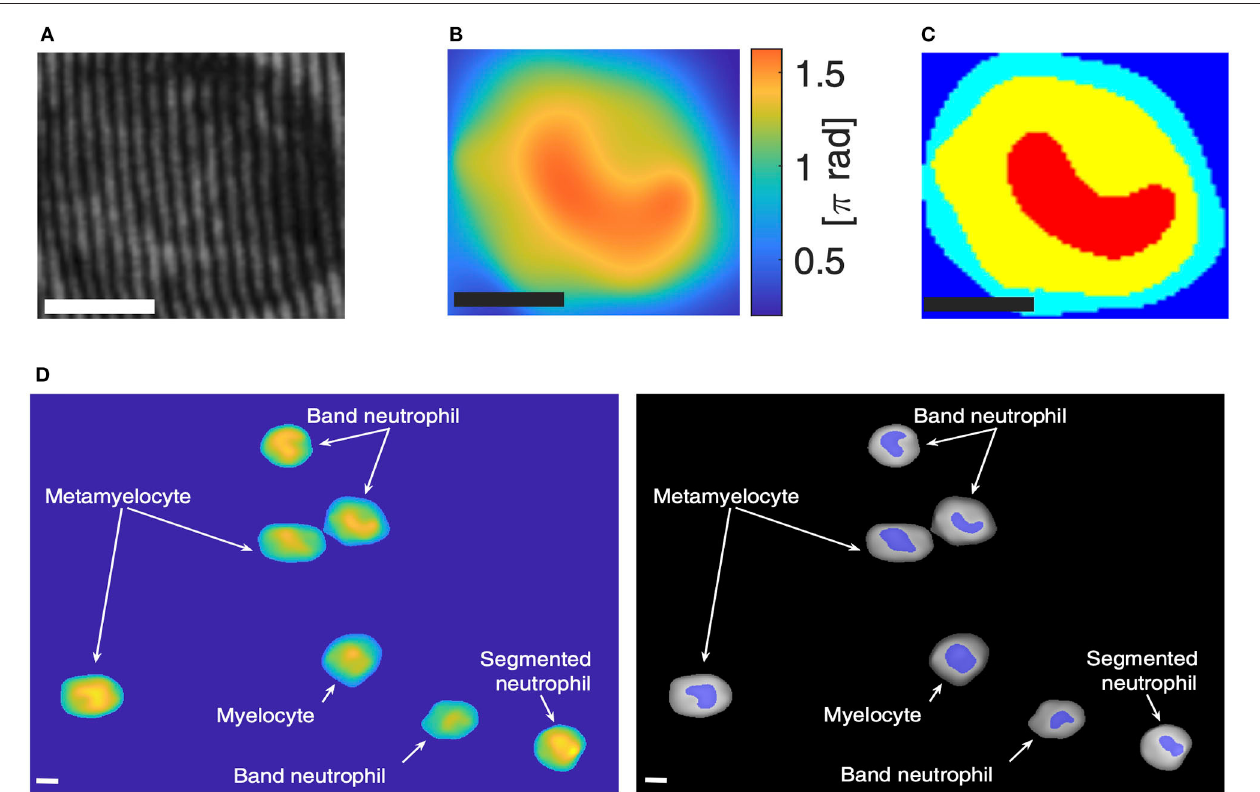
FIGURE 1 | Optical phase (OP) reconstruction and cell selection. (A) Recorded hologram, (B) reconstructed OP, (C) segmentation, (D) full field image taken at day 5 showing different types of cells; left: after cell selection, the colors indicate cell height; right: cell and nucleus regions are shown after cell and nucleus selection. Scale bars: 5 µ m